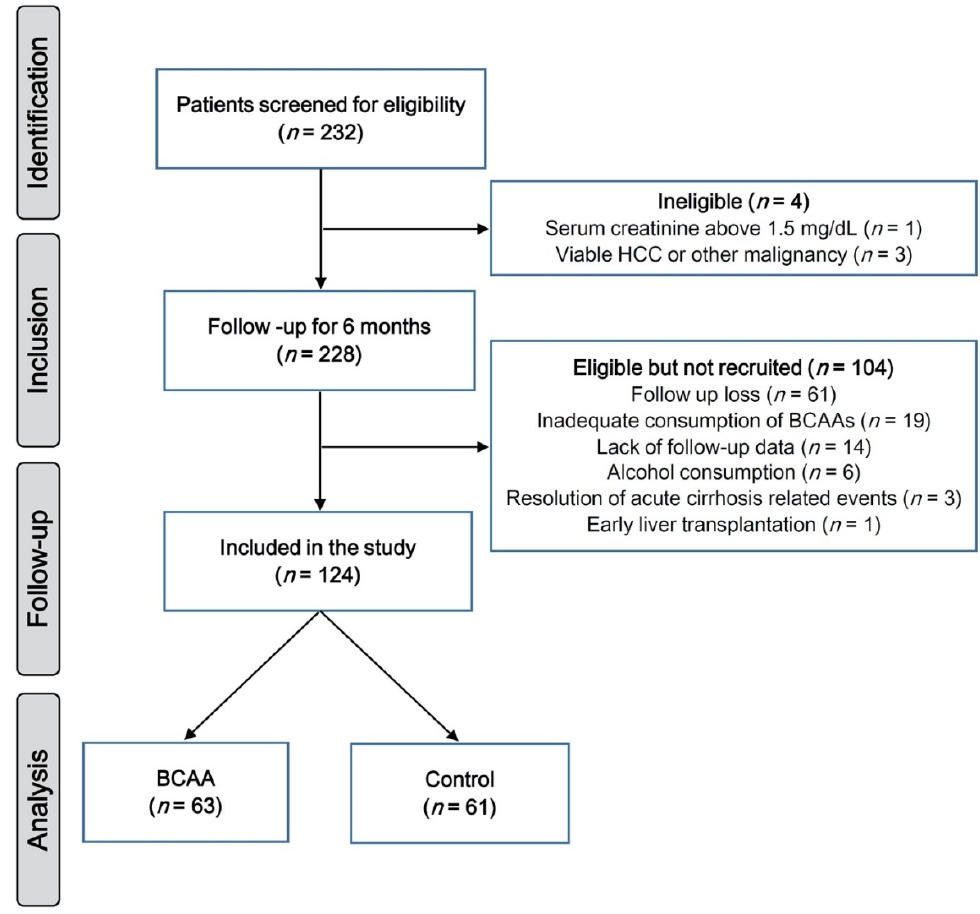
Figure 2. Flow diagram of the study. HCC, hepatocellular carcinoma; BCAA, branched-chain amino acid.